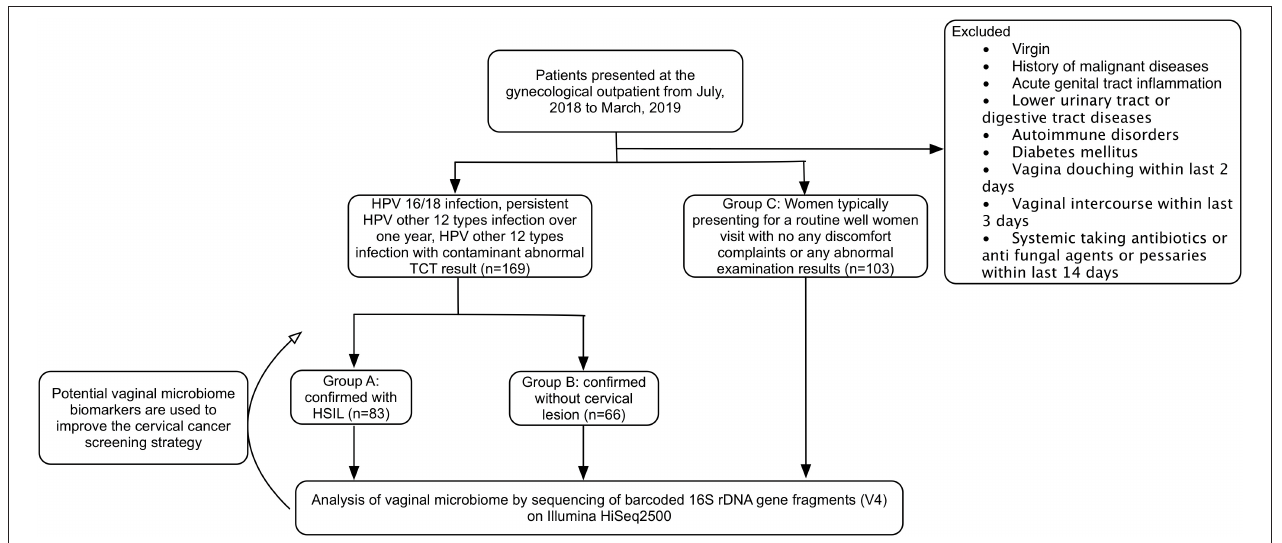
FIGURE 1 | CONSORT flow diagram of the study. HPV, human papilloma virus; HSIL, high-grade squamous intraepithelial lesion; TCT, ThinPrep ® Pap testing.